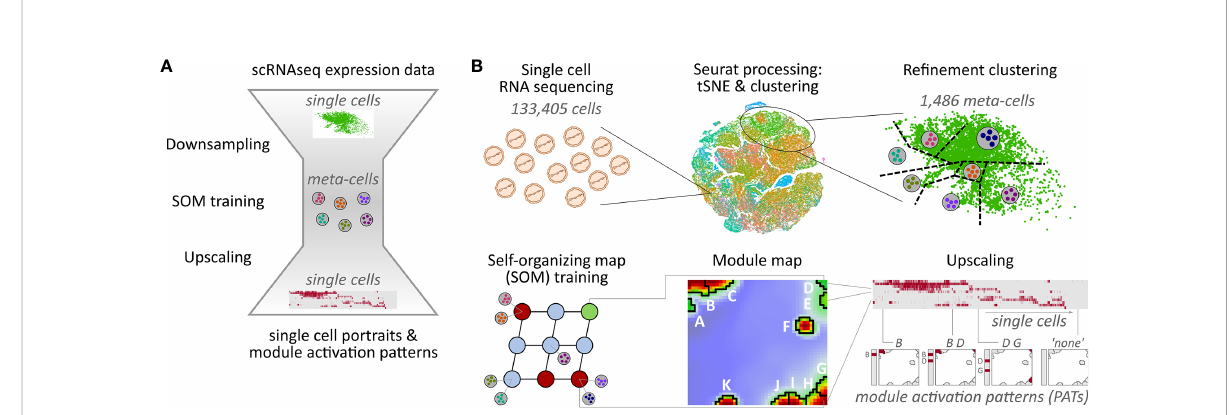
FIGURE 1 Overview of the downsampling and upscaling processes: (A) In short: Single-cell RNA sequencing data is reduced to meta-cell data. After self- organizing map (SOM) training using these meta-cells, data is upscaled to single-cell resolution. (B) In detail: scRNAseq data of 133,405 cells was used to generate tSNE and cell clusters using standard Seurat preprocessing work fl ow. The resulting clusters were then further divided in a re fi nement clustering step, resulting in 1,486 meta-cells. Expression data of these meta-cells were used for SOM training followed by de fi nition of eleven expression modules A – K Finally, analysis is upscaled to single-cell level by calculating module expression data for each single cell, and strati fi cation of the data by patterns of module activation